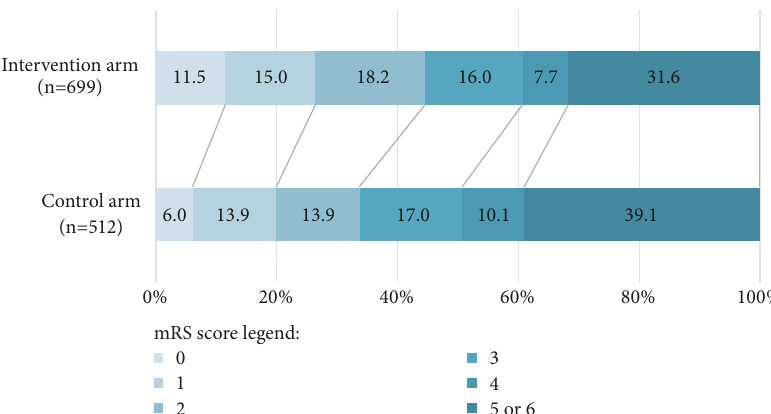
Figure 3: Pooled modified Rankin Scale (mRS) scores at long-term follow-up . Numbers represent percentages of patients in each outcome group. mRS range is 0-6: 0 indicating no symptoms, 1 no clinical disability, 2 slight disability, 3 moderate disability, 4 moderately severe disability, 5 severe disability, and 6 death. Percentages are rounded to the nearest whole